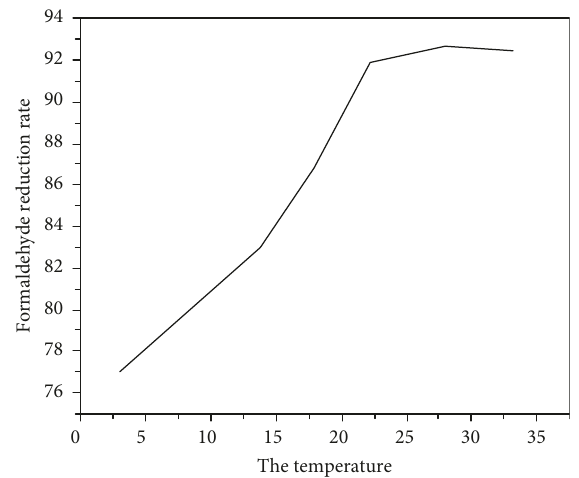
Figure 4: Influence of temperature on the formaldehyde degra- dation rate of photocatalytic coatings.